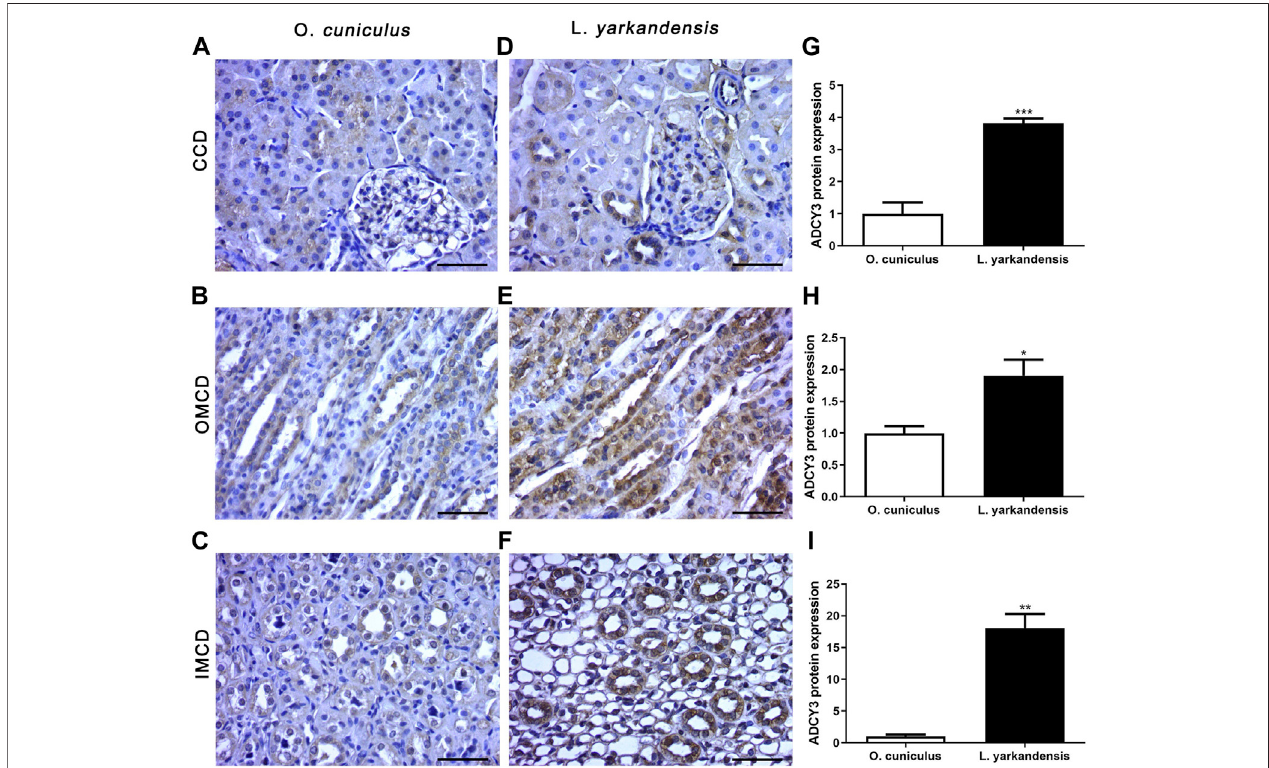
FIGURE 6 | ADCY3 protein distribution in renal CCD, OMCD, IMCD in a tissue section of O. cuniculus (A-C) and L. yarkandensis (D-F). Paraf fi n sections (6 µm) of renal cortex and medulla of O. cuniculus and L. yarkandensis (A-F) . The sections were incubated with an anti- ADCY3 antibody scale bar 50 µm. Densitometry of all immunohistochemistry results of renal CCD and OMCD and IMCD from O. cuniculus and L. yarkandensis (n = 6 for each group), ppp p < 0.001, pp p < 0.01, and p p < 0.05 (G-I) . Average density showed a signi fi cant higher expression of ADCY3 protein abundance in CCD and OMCD and IMCD of L. yarkandensis compared to that of O. cuniculus (G-I)